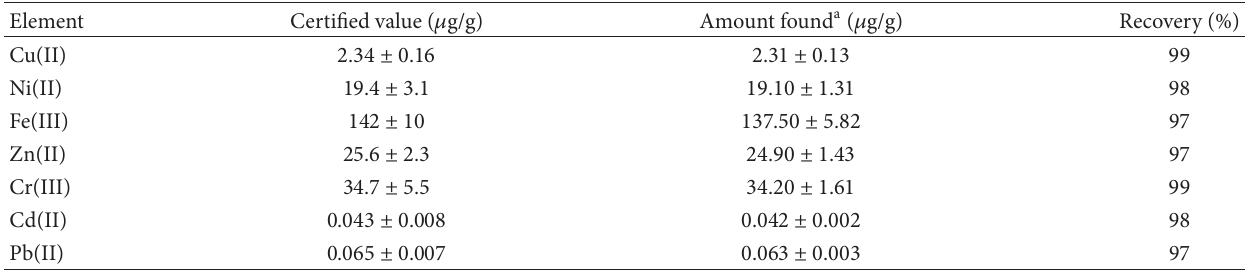
a Mean ± SD (standard